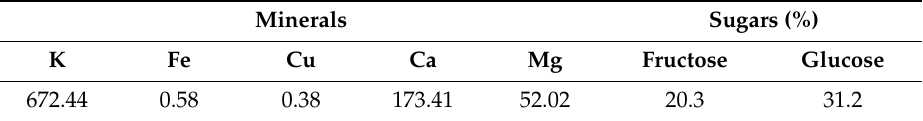
Table 4. Content of minerals (mg / 100 g) or sugars (%) in lyophilized Cornus mas